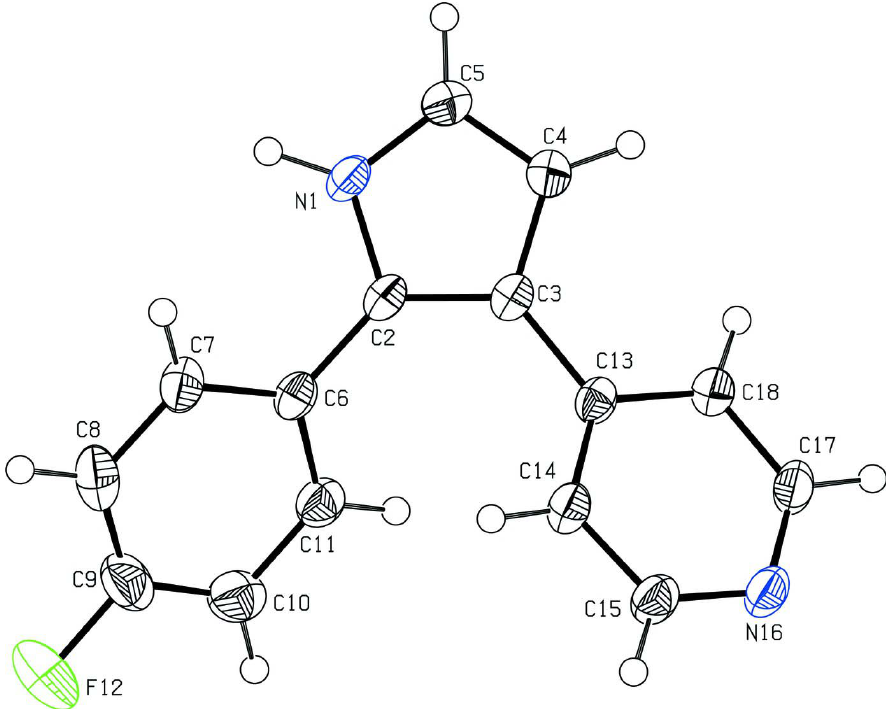
Figure 1 View of the title compound. Displacement ellipsoids are drawn at the 50% probability level. H atoms are depicted as circles of arbitrary